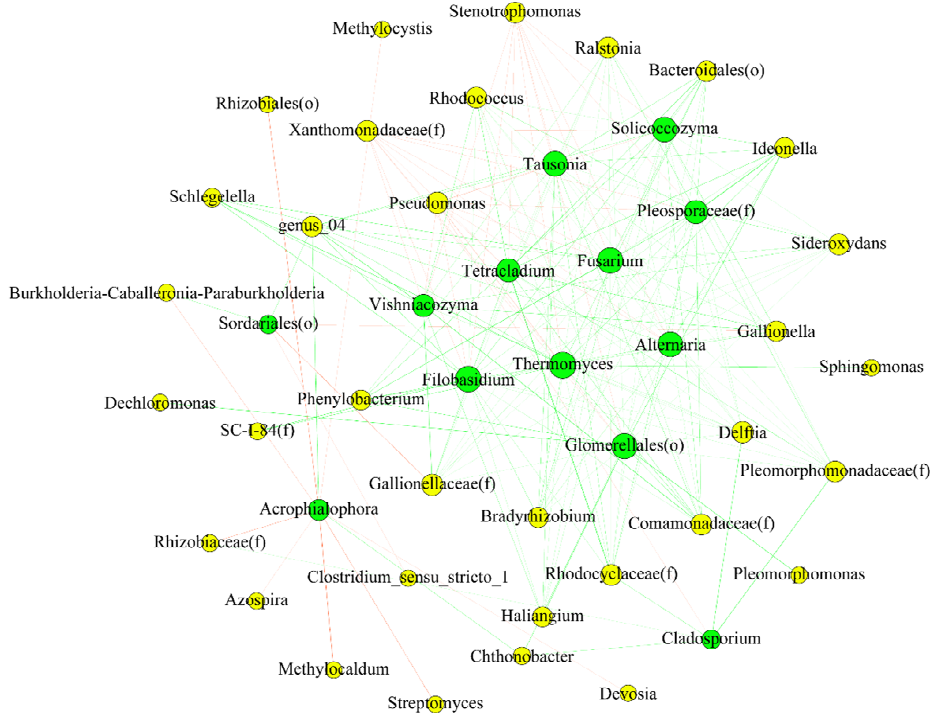
Figure 8. Correlation network diagram of bacteria and fungi at the genus level in rice. The species with significant differences ( p < 0.05) were selected, and correlation coeffi- cients, such as Spearman ranks, were calculated between species to reflect the correlation between species. The size of the node in Figures 8 and 9 represents the species abundance, the yellow node represents bacteria, and the green node indicates fungi. The color of the line indicates positive or negative correlation, where red indicates a positive correlation and green indicates a negative correlation. The thickness of the line indicates the size of the correlation coefficient, and the thicker the line, the higher the correlation between species. The more lines, the closer the connection between the